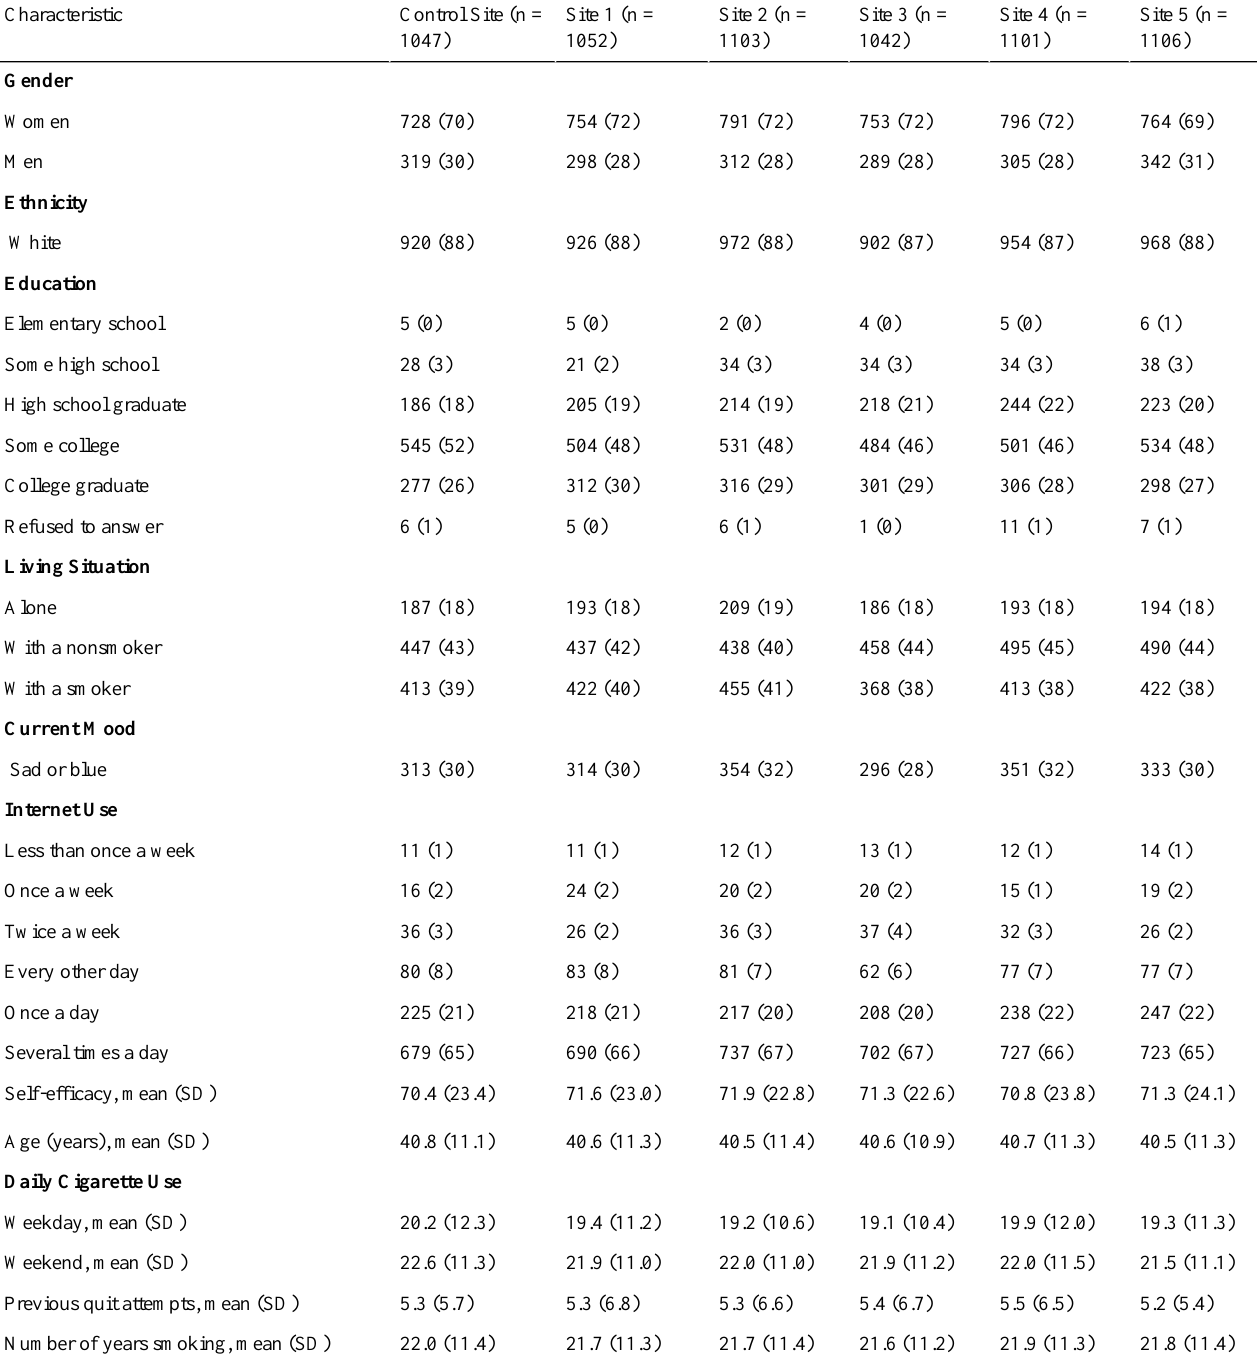
Table 2. Participant baseline characteristics by group